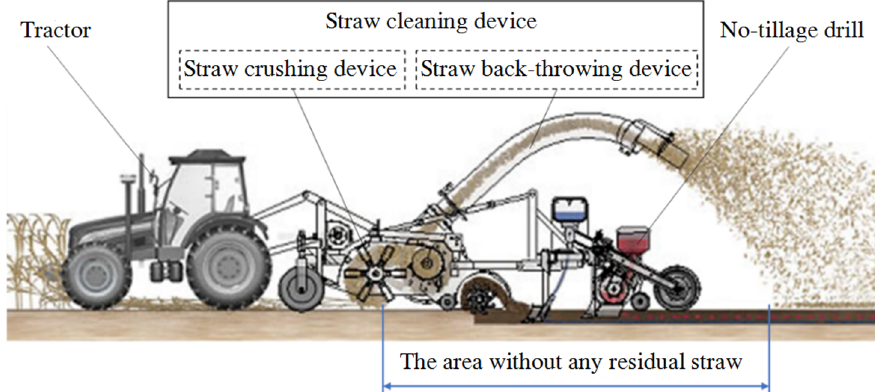
Figure 1. Operation principle of no-tillage drill under full straw retention.